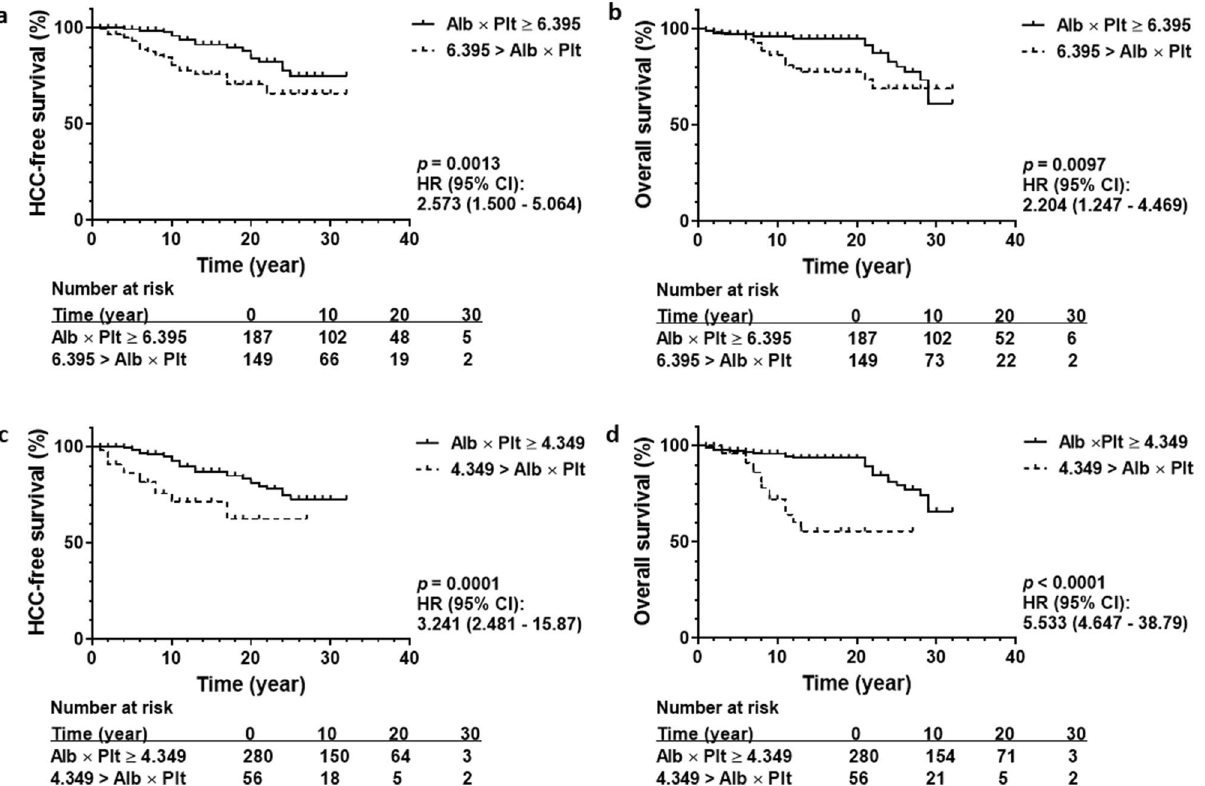
Figure 4. HCC-free survival and overall survival in a training cohort. Among 336 patients followed up for at least 1 year, 45 patients were complicated with HCC and 42 patients died. An Albumin platelet product cut-off value = 6.395 could differentiate HCC-free survival ( a ) and overall survival ( b ) in the Kaplan–Meier analysis. Albumin platelet product = 4.349 also predicted a difference in HCC-free survival ( c ) and overall survival ( d ) with statistical significance. P values less than 0.05 were considered statistically